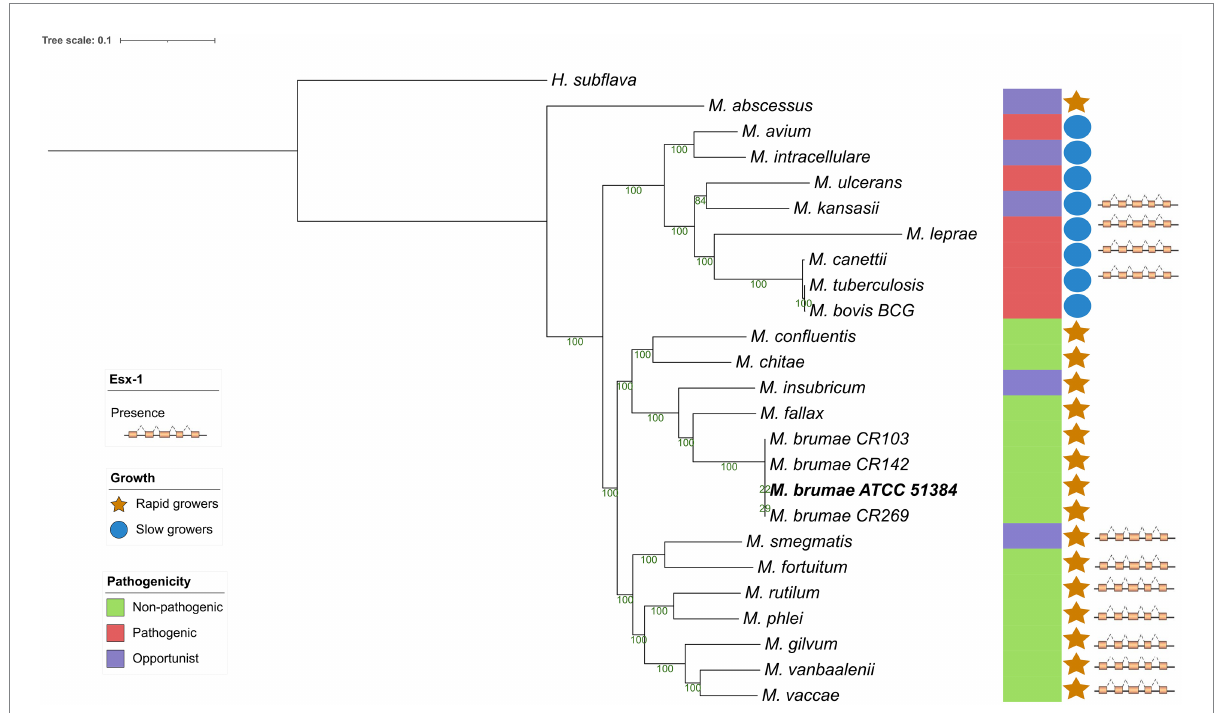
FIGURE 4 Phylogenetic relationship of Mycobacterium brumae within the Mycobacterium genus. Maximum likelihood phylogenetic tree of type strains from the Mycobacterium genus based on an alignment with 177 core genes, highlighting the position of M . brumae ATCC 51384 T type strain. GTR model was used with bootstrap confidence of 1,000 replicates. Branch lengths are proportional to nucleotide substitutions and the topology is rooted with Hoyosella subflava . The phylogenetic tree was annotated with the pathogenicity, the ESX-1 presence or absence, and the growth rate (see